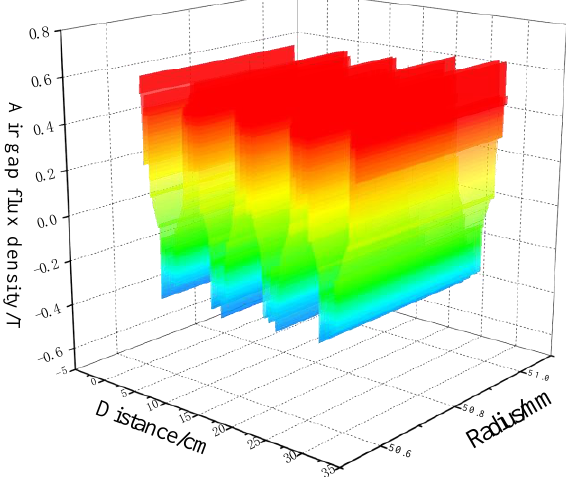
Figure 6. Magnetic density distribution of air gap at the root of the claw pole.